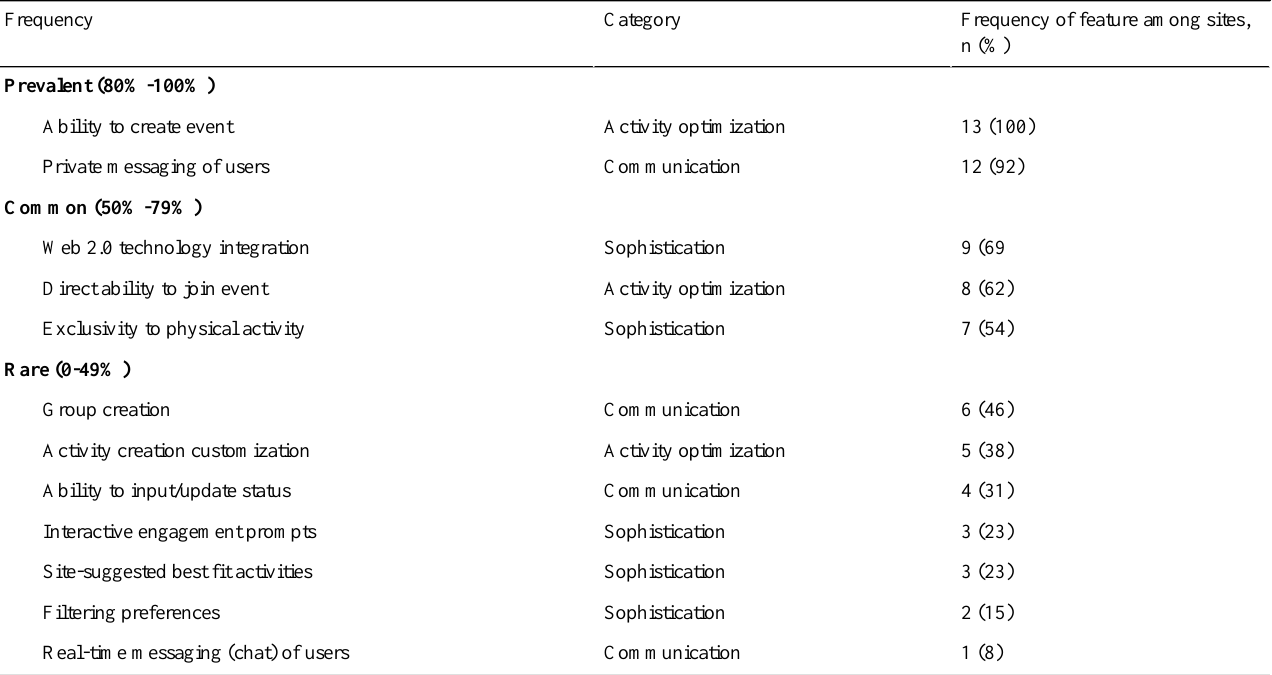
Table 3. Features of online social networks categorized according to frequency (prevalent, common, or rare; N=13).